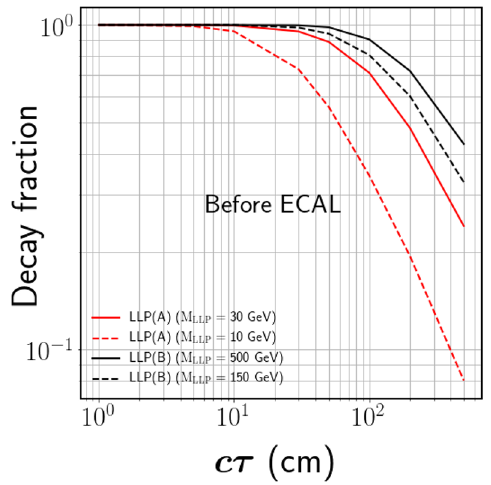
Figure 1 . Fraction of events decaying before the ECAL, i.e., within a radial distance of 1.29 m, and half-length of 3 m, as a function of the mean proper decay length ( cτ ) of the LLP having a mass of 10 GeV and 30 GeV in scenario (A), and 150 GeV and 500 GeV in scenario